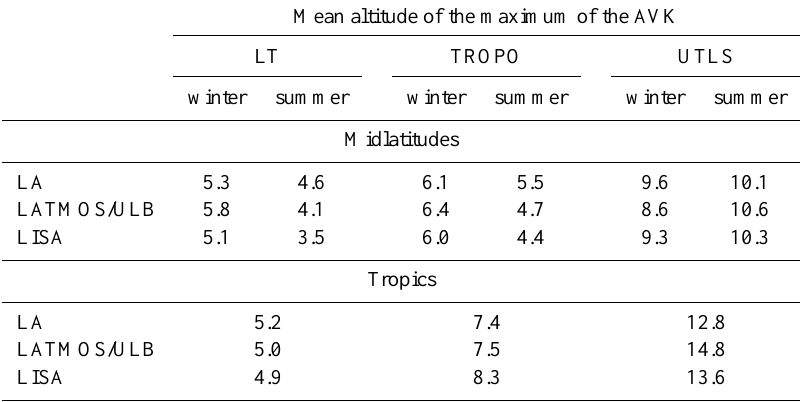
Table 5. Altitude, in km, of the maximum of the averaging kernel (AVK) of different partial columns of ozone averaged over the sets of pixels in coincidence with the ozonesondes defined for each group (LA, LATMOS/ULB, LISA). The altitude is given in the midlatitudes and in the tropics separately as well as for winter and summer of the northern